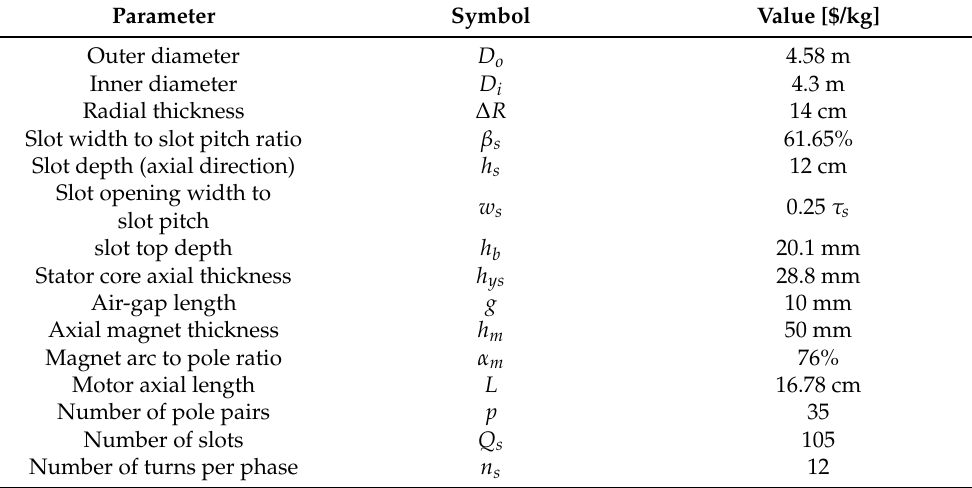
Table 7. Optimal AFPM machine design sizes.